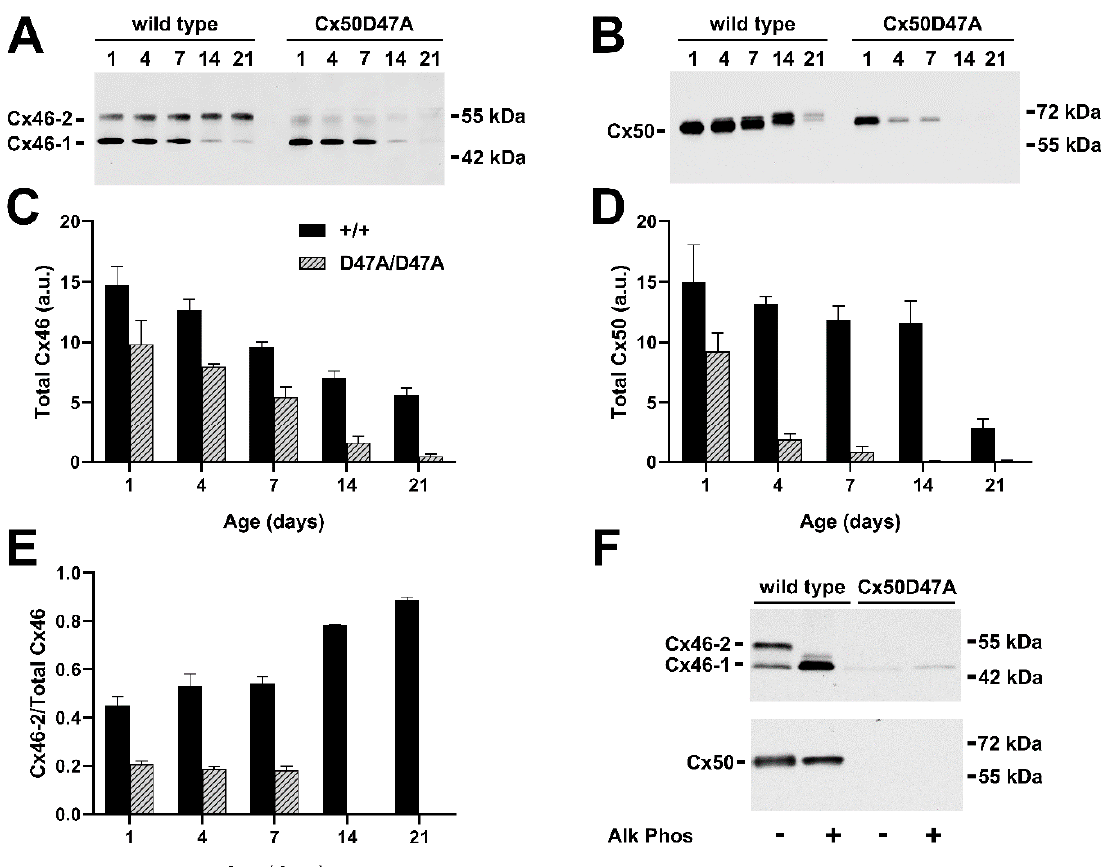
Figure 3. Immunoblot detection and quantification of Cx46 and Cx50 at various post-natal ages in wild-type and Cx50D47A mice. ( A , B ) Immunoblots of Cx46 ( A ) and Cx50 ( B ) in lens homogenates from 1-, 4-, 7-, 14-, and 21-day-old wild-type and homozygous Cx50D47A mice (C3H background). The two major Cx46 bands are indicated as Cx46-1 and Cx46-2. The migration positions of the molecular mass markers are indicated on the right. ( C , D ) Graphs show the mean (bar) + SEM of the densitometric values of the immunoreactive Cx46 bands ( C ) and Cx50 bands ( D ) obtained from three independent experiments expressed in arbitrary units (a.u.). ( E ) Graph shows the mean (bar) + SEM of the ratio of Cx46-2 to total Cx46 from densitometric analysis of three independent experiments. ( F ) Immunoblot detection of Cx46 (upper panel) and Cx50 (lower panel) in homogenates from the lenses of 7-day-old wild-type or homozygous Cx50D47A mice after incubation in the absence or presence of alkaline phosphatase (Alk Phos). The two major Cx46 bands are indicated as Cx46-1 and Cx46-2. The migration positions of the molecular mass markers are indicated on the